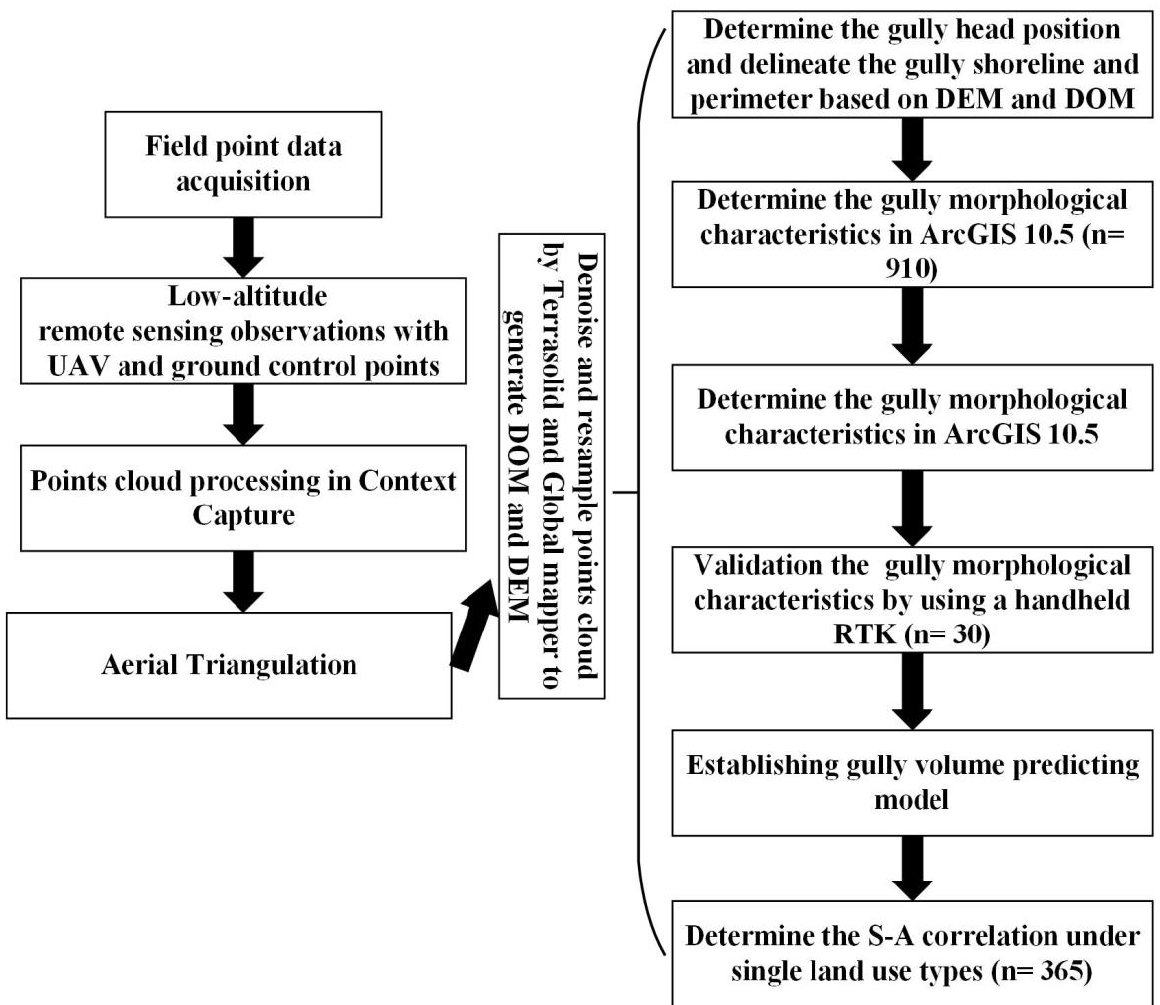
Figure 2. The methodologies applied in this study (UAV, unmanned aerial vehicle; DOM, digital orthophoto map; DEM, digital elevation map).